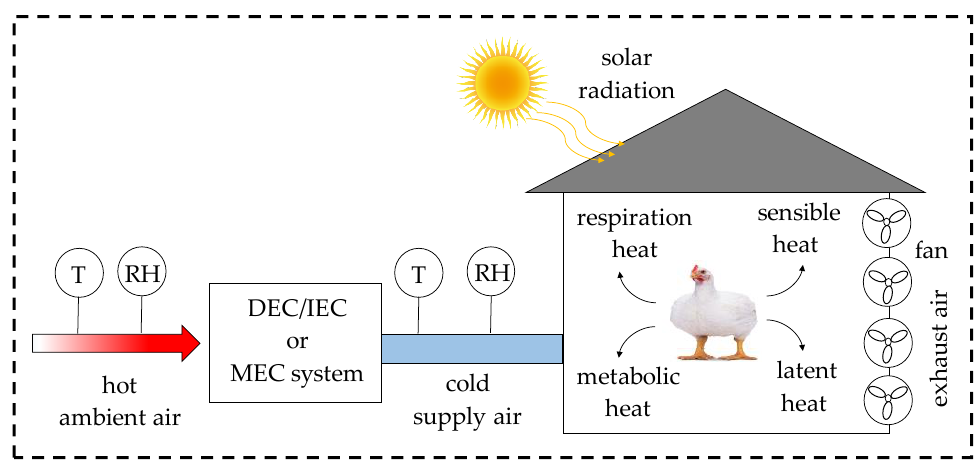
Figure 5. Scheme of temperature and humidity control system(s) in a typical poultry shed for maintaining the thermal comfort of poultry birds.